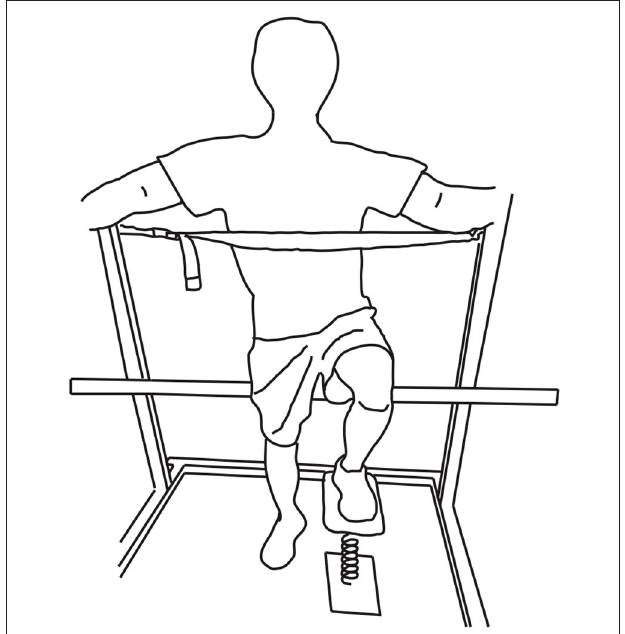
FIGURE 1 | LED test positioning. Subjects placed the tested leg on the LED test system while partly seated on a bicycle seat. The height of the bicycle seat was adjusted for the contralateral foot to make complete contact with the ground. A strap at the height of the xiphoid process and safety bars were used for additional